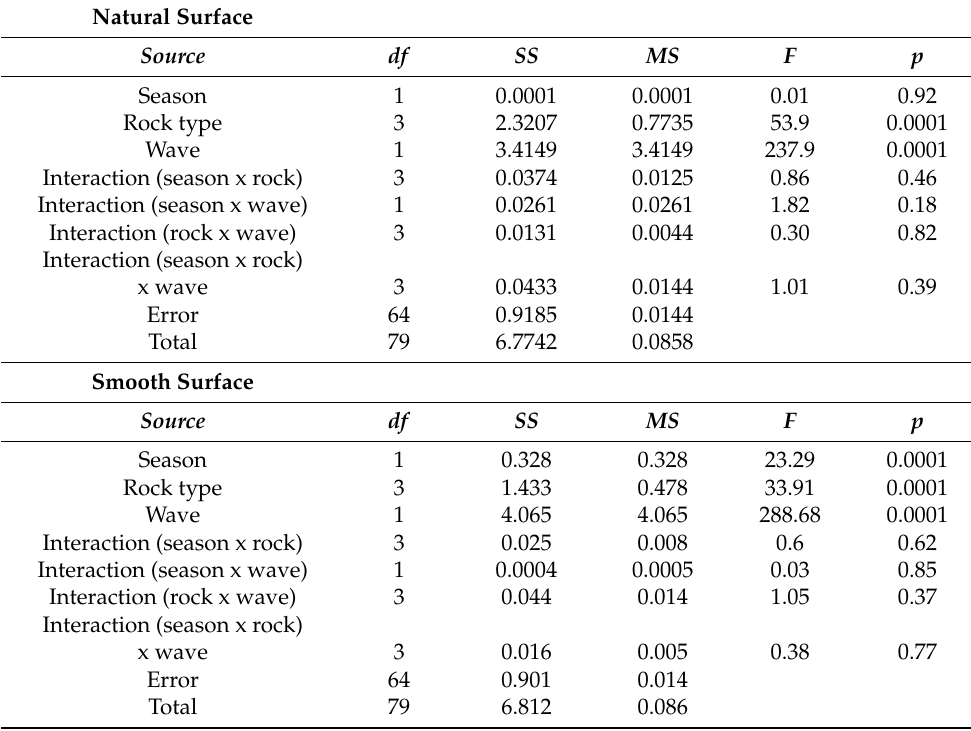
Table 1. Results of 3-way ANOVA analyzing the effect of season (summer and winter), rock type (limestone, schist, basalt, and granite), and wave or no wave on the density of zygotes recorded on settlement plates of natural and smooth surfaces. There were 5 replicate plates of each rock type and flow combination. Data were log 10 -transformed before